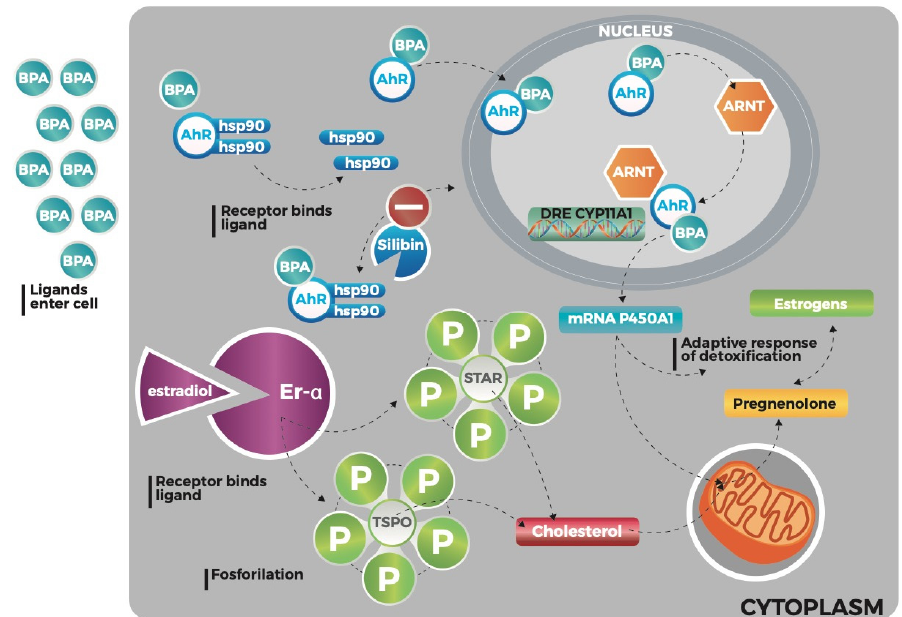
Figure 6. The bisphenol A-induced synthesis of steroids: The bisphenol A (BPA) spreads out through the membrane and binds the cytosolic multi-protein aryl hydrocarbon receptor (AhR), allowing its release in the cytoplasm by the heat shock protein (hsp)-90. Then the ligand-AhR complex dimerizes with a nuclear protein AhR Nuclear Translocator (ARNT): this process converts the AhR into the high affinity binding DNA form. The binding of the multimiginous complex ligand AhR-ARNT to its specific DNA recognition site stimulates the transcription of these genes with subsequent production of mRNA for cytochrome P450A1. Cytochrome P450A1 activates an adaptive detoxification response and stereogenesis by inducing the conversion of cholesterol into pregnenolone, which in turn will enter the steroid hormone synthesis pathway. In the meantime, the activation of estrogen receptor- alpha, due to the excess of estrogens for the aromatase functioning, induces the activation of steroidogenic acute regulatory protein (STAR) and translocator protein (18 kDa) (TSPO) that in turn enhance the transport of cholesterol across the mitochondrial membrane.